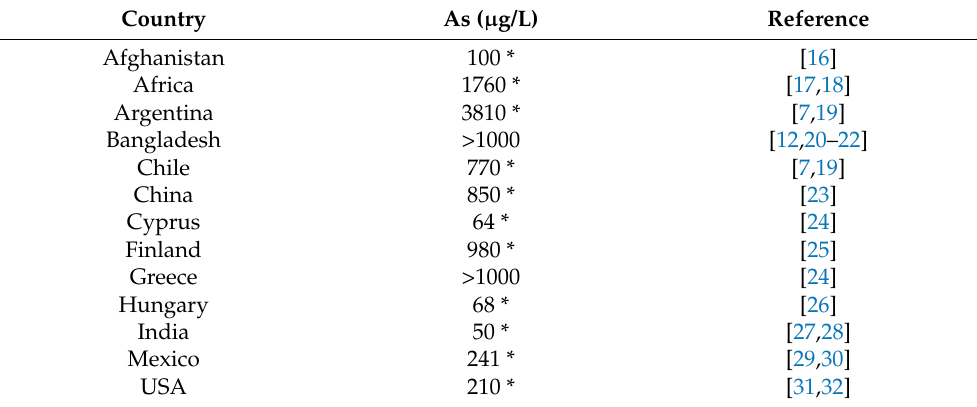
Table 1. Reported occurrences of high arsenic concentration in groundwater worldwide. Country As ( µ